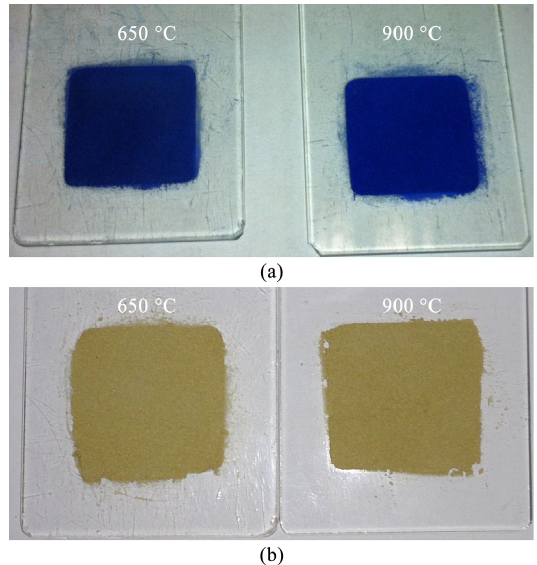
Figure 3. Images of (a) CoAl at different temperatures.